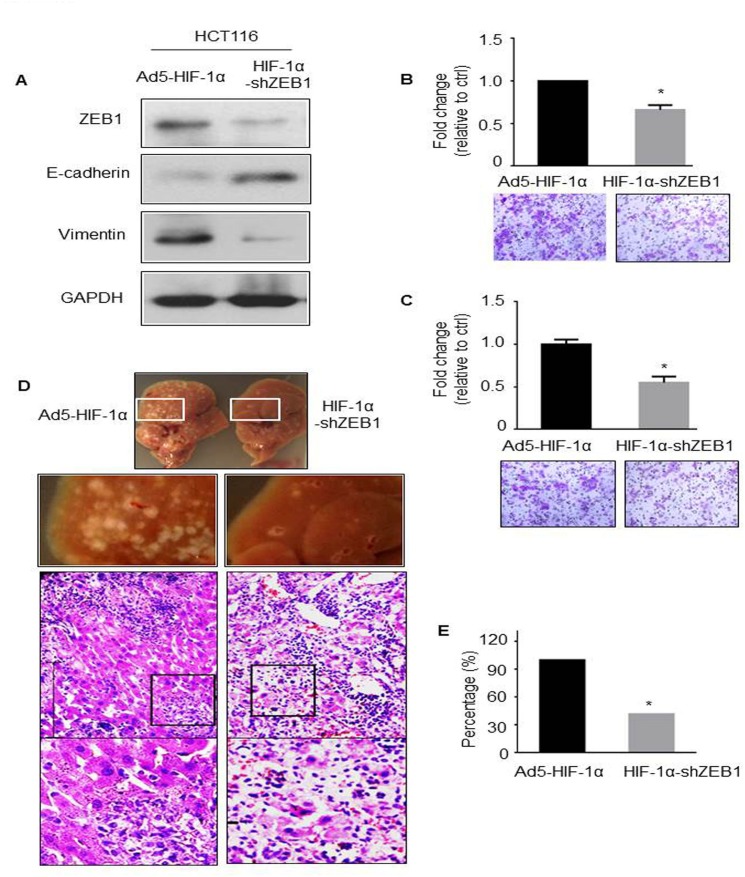
ZEB1 inhibition abolished HIF-1α-induced EMT and metastasis.(A) Western blot analysis of ZEB1, E-cadherin and Vimentin in HCT116-Ad5-HIF-1α or HCT116-HIF-1α-shZEB1 cells. GAPDH was used as the loading control. Invasion (B) and migration (C) assays were performed in the same two cell lines. The representative images of invaded cells in the inserts of transwell chambers were shown at original magnification = 200X. *P < 0.05. (D) Representative photographic pictures and H&E staining of liver of BALB/c mice 5 weeks after subsplenic injection of HCT116-Ad5-HIF-1α or HCT116-HIF-1α-shZEB1 cells. (E) Quantification of the average numbers of metastatic foci in the livers of mice (N = 5). *P < 0.05.